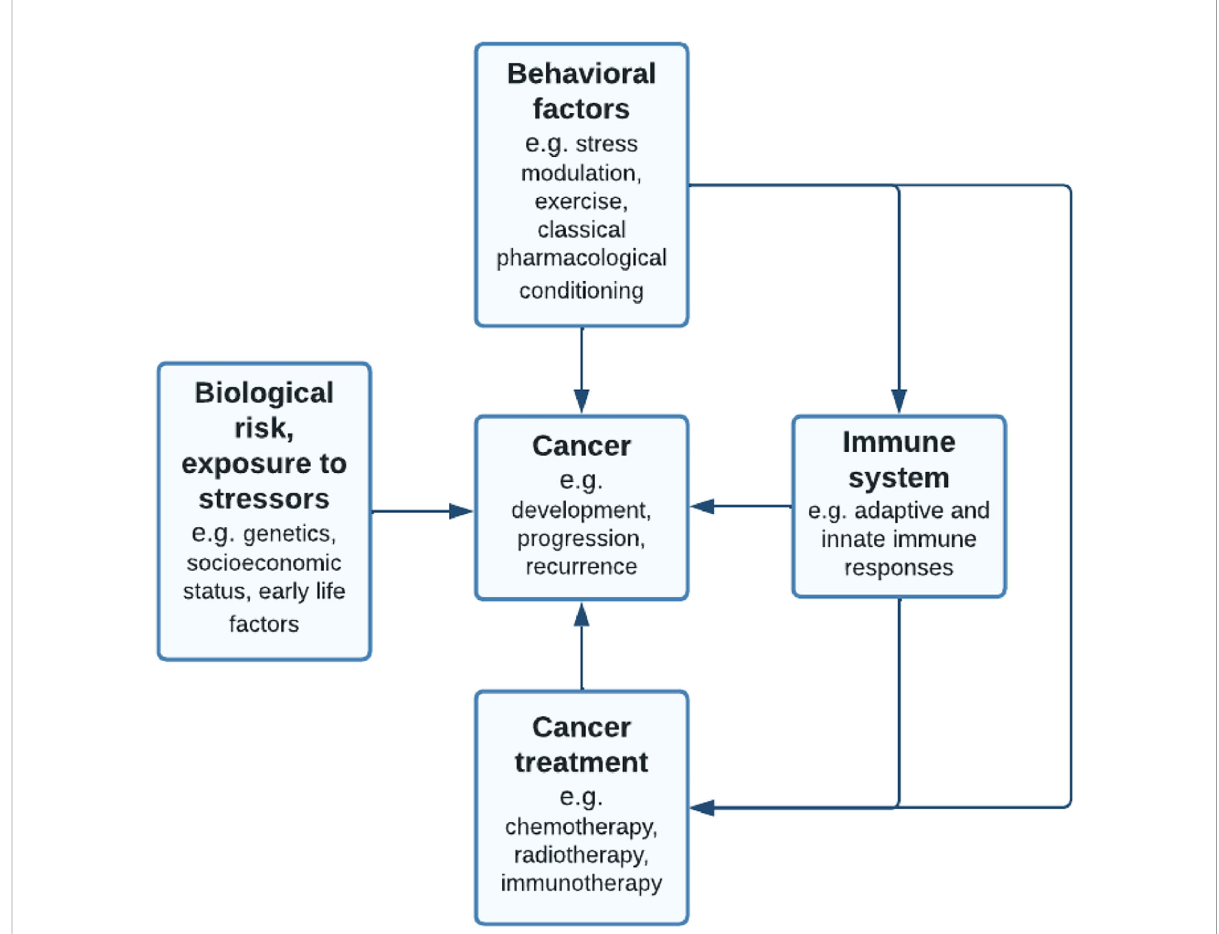
FIGURE 1 Adapted vulnerability-stress model (36): pathways linking behavioral factors to cancer. The behavioral medicine (37) model suggests that while individuals inherit biological risks such as genetic predisposition to cancer, this vulnerability requires interaction with stressors such as chronic traumatic events. Next to this, lifestyle behavior or behavioral interventions may in fl uence cancer development, progression or recurrence, mediated by the immune system. Behavioral factors such as stress modulation, exercise and classical pharmacological conditioning are suggested to in fl uence both conventional cancer treatments, such as chemotherapy, as well as immune checkpoint inhibition